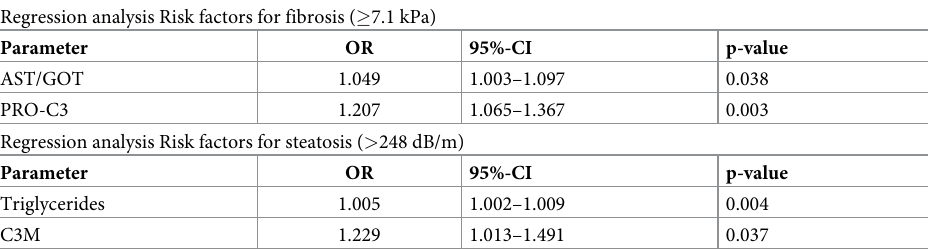
Table 3. Regression analysis for independent risk factors. AST: aspartate